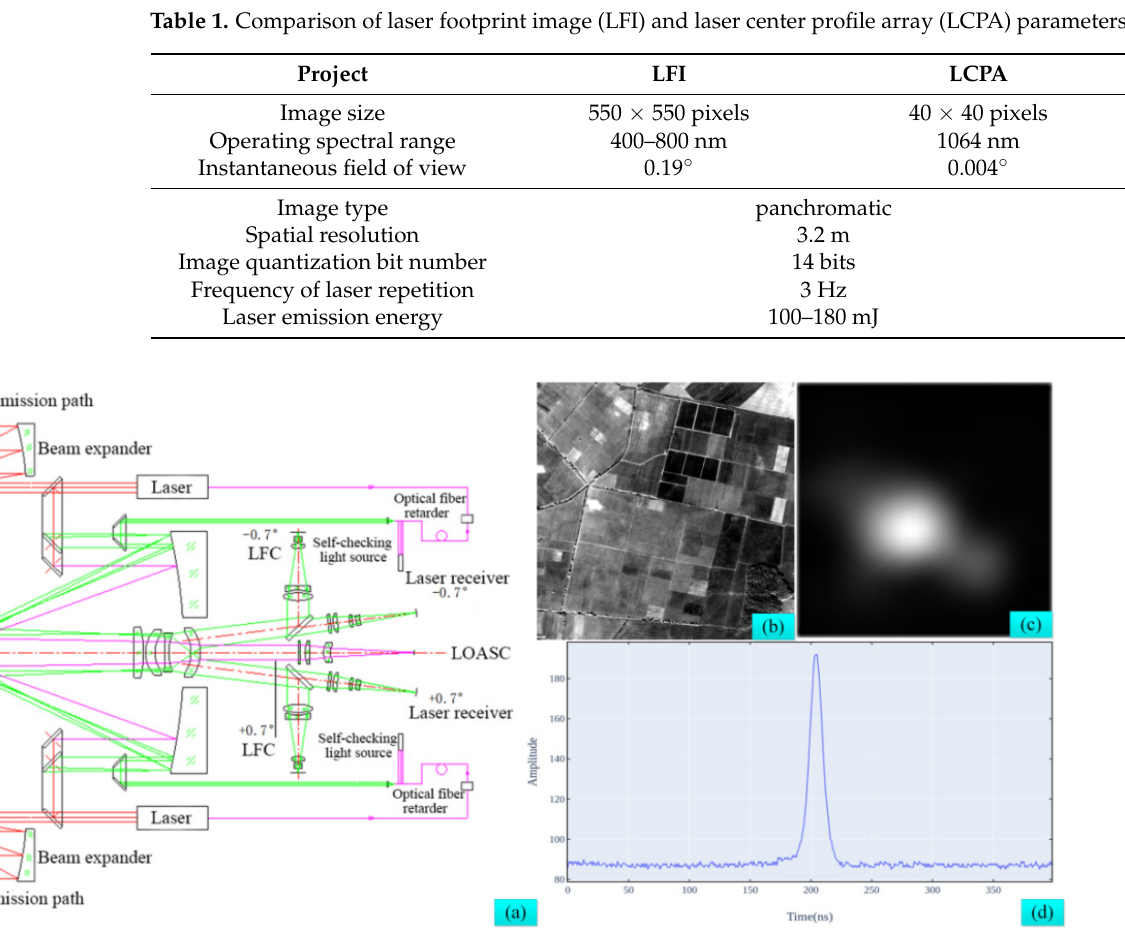
Figure 1. ( a ) Optical path of the laser system. ( b ) Laser footprint image. ( c ) Laser center profile array. ( d ) Laser emissions waveform. Table 1. Comparison of laser footprint image (LFI) and laser center profile array (LCPA) parameters.